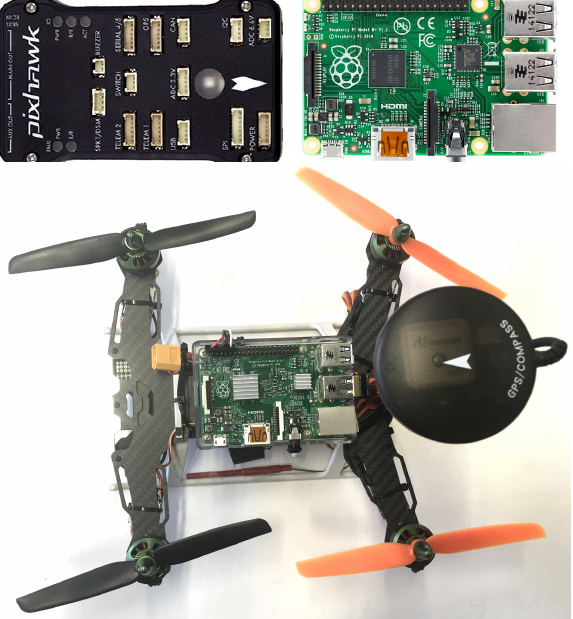
Figure 1. (top left) The pixhawk flight module / autopilot, (top right) the Raspberry Pi 2 and (bottom) one of the NEC MSP